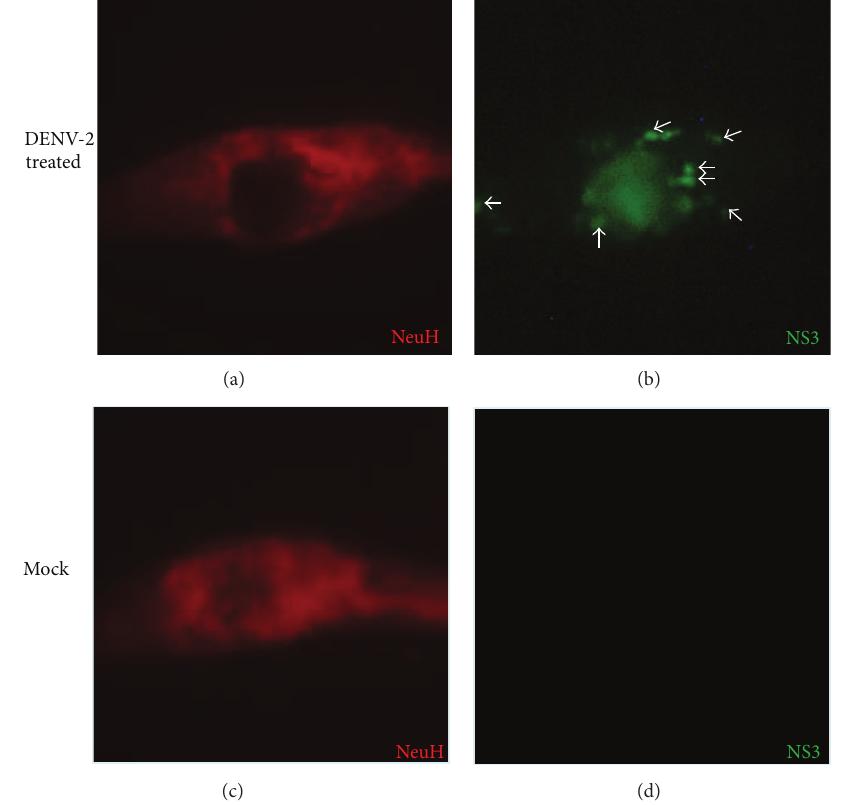
Figure 4: Detection of DENV replication in neurons. Cells in mixed primary cell cultures from human CNS treated with DENV-2 were examined after 5 days by indirect immunofluorescence in an epifluorescence microscope. The monoclonal antibody raised against NS3 DENV allowed the assessing of the active viral replication in the brain primary cell cultures, (b) and (d) while the antibody cell markers enable the identification of the cell type as neurons. (c) and (d) Original magnification was 600x, but the pictures were cropped to improve presentation. Arrows point to virus replication sites in human